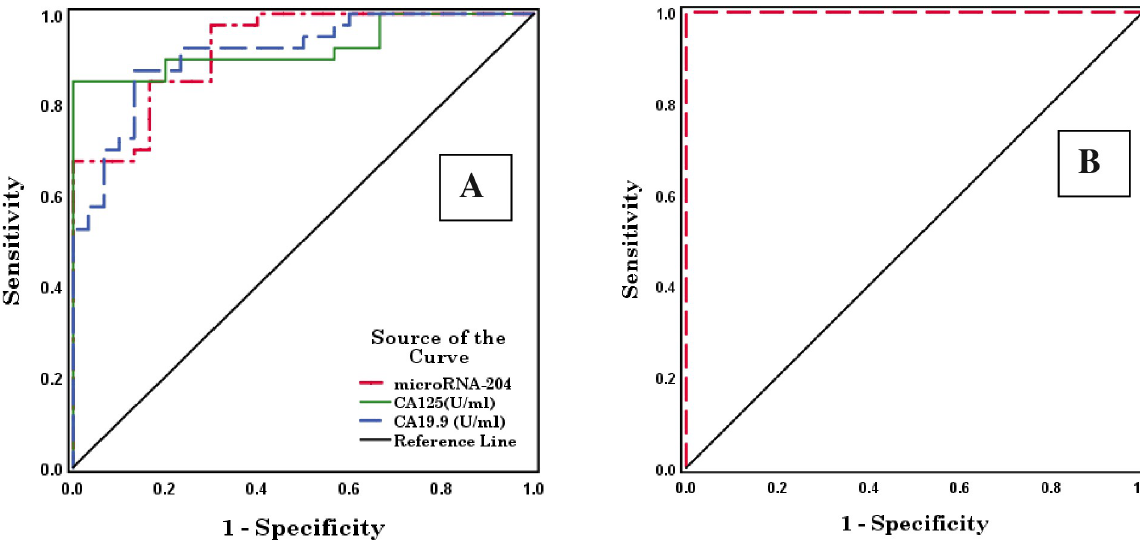
Fig 2. Receiver operating characteristic (ROC) curves of microRNA-204, CA125, and CA19.9 (A) and combined microRNA-204, CA125, and CA19.9 (B) in early ovarian cancer patients.